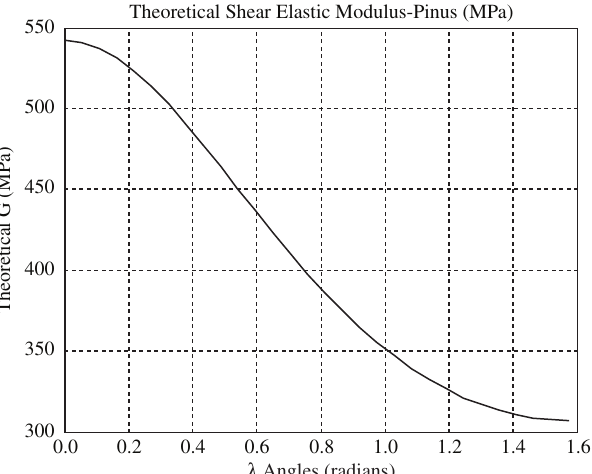
Figure 12. Lateral view diagram of Shear Elastic Modulus and Euler’s angles for Pinus.